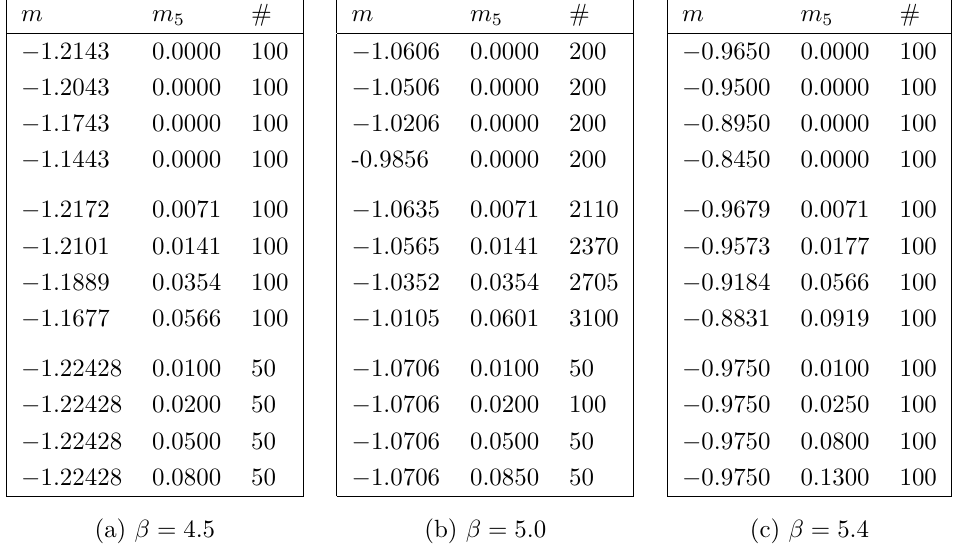
Table 7 . Ensemble sizes on the 16 3 × 32